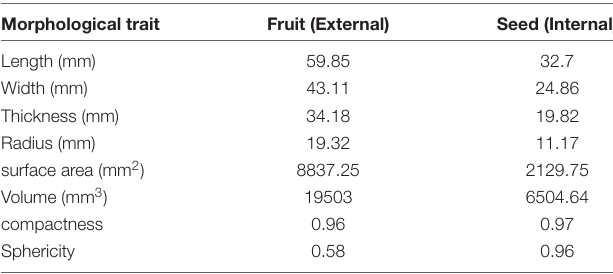
TABLE 3 | The fruit and seed phenotypes of draft Russian almond extracted from X-ray computed tomography images using the 3DPheno-Seed&Fruit software. Morphological trait